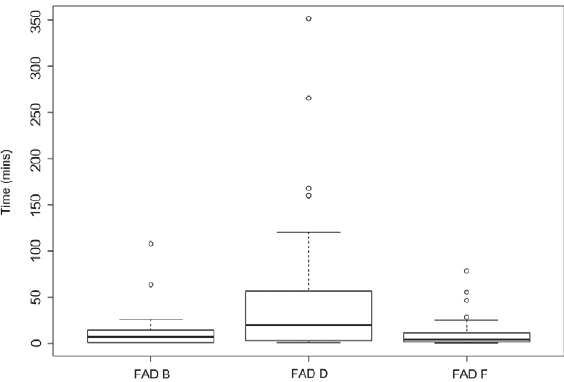
Fig. 3. – Simultaneous familywise confidence intervals (P<0.05) for the probability of vessel presence by day of week and time of Fig. 2. – Cumulative presence (minutes/d) of vessels that could not day interval in chronological order (early am to late pm: a to d) at be cross-identified or classified at FAD B, D and F off San Juan, moored FADs off San Juan, Puerto Puerto Rico.